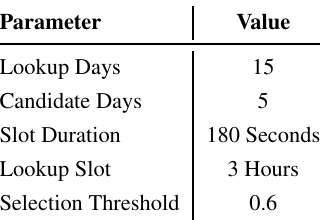
Figure 5: Cumulative Distribution of Prediction Performance over